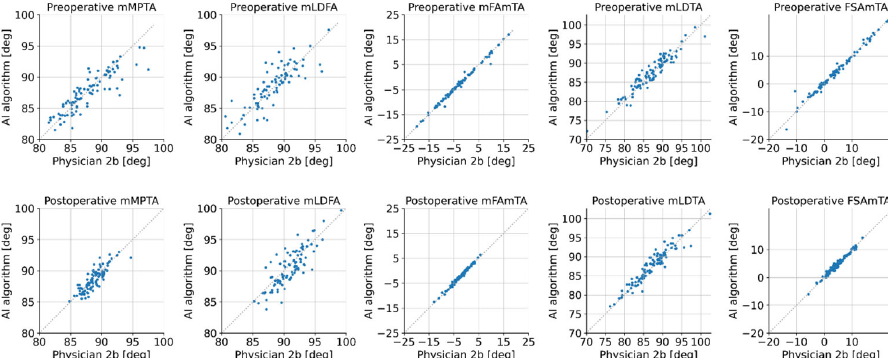
Figure 2. Correlations between the manual measurements of rater 2b on the x-axes and the automatic measurements by the AI algorithm on the y-axes, respectively.